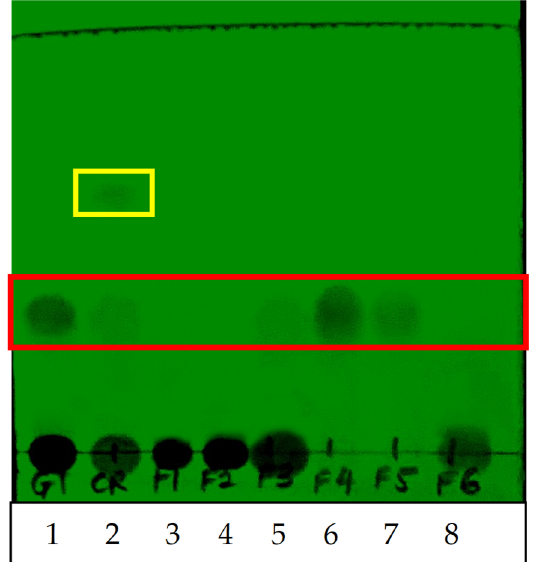
Figure 2. Thin-layer chromatography (TLC) plate analysis to detect the gallotannin compound using short UV wavelength (254 nm). Lane 1 = gallotannin synthetic compound (positive control); Lane 2 = QI gall crude aqueous extract; Lane 3 to Lane 8 = QI gall fractionated extracts F1 to F6. Red box indicates that gallotannin compound was detected in crude extract, F3, F4 and F5, while the yellow box indicates that an additional unknown compound was detected in the crude extract only.